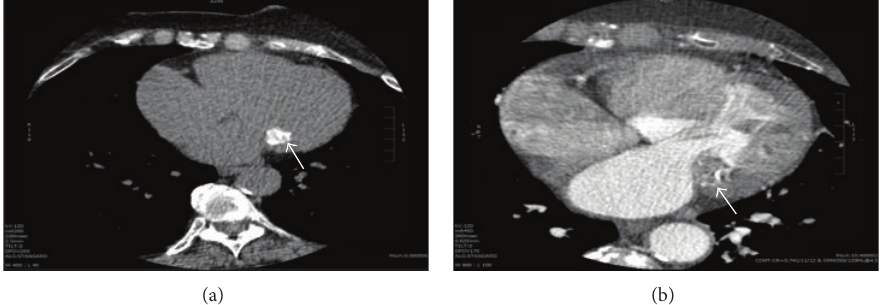
Figure 3: Chest CT scan without and with contrast. A 17 × 18mm round hyperdense mass was identified (white arrow) along the mitral valve annulus (a). There is a heterogeneous calcification pattern with a hypoattenuated necrotic center